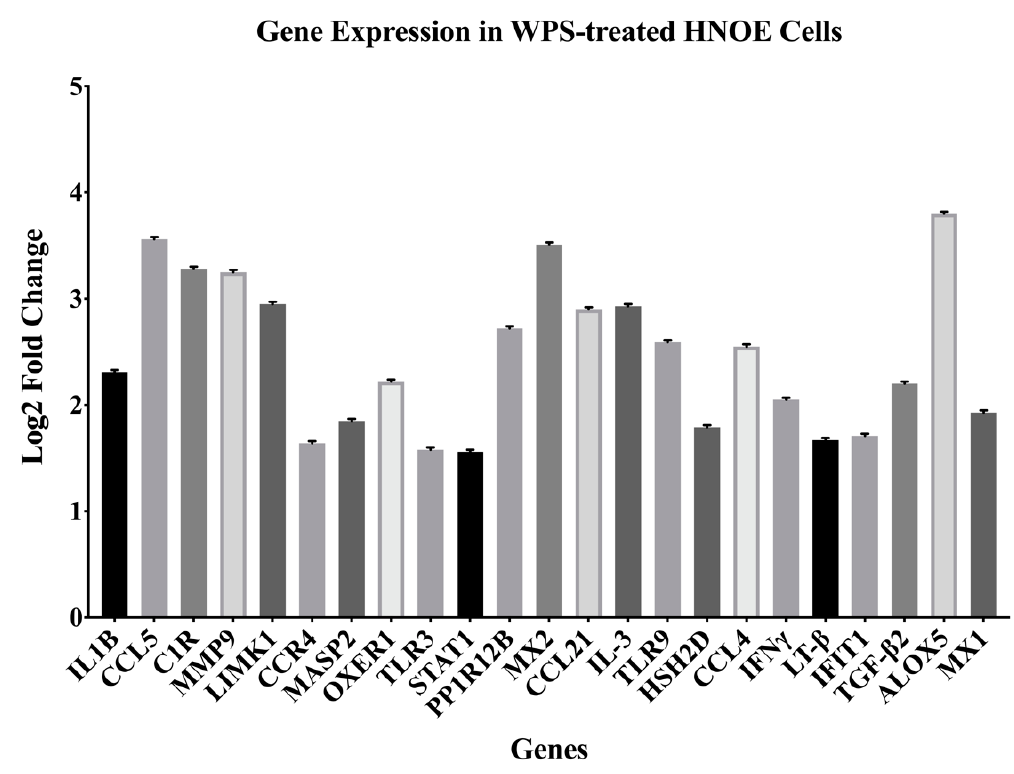
Figure 2. Differentially expressed genes (DEGs) discovered using the NanoString PanCancer Pathway Panel. Cut-offs used were 1.5-fold change or high between the different groups and adjusted for p -value < 0.05.